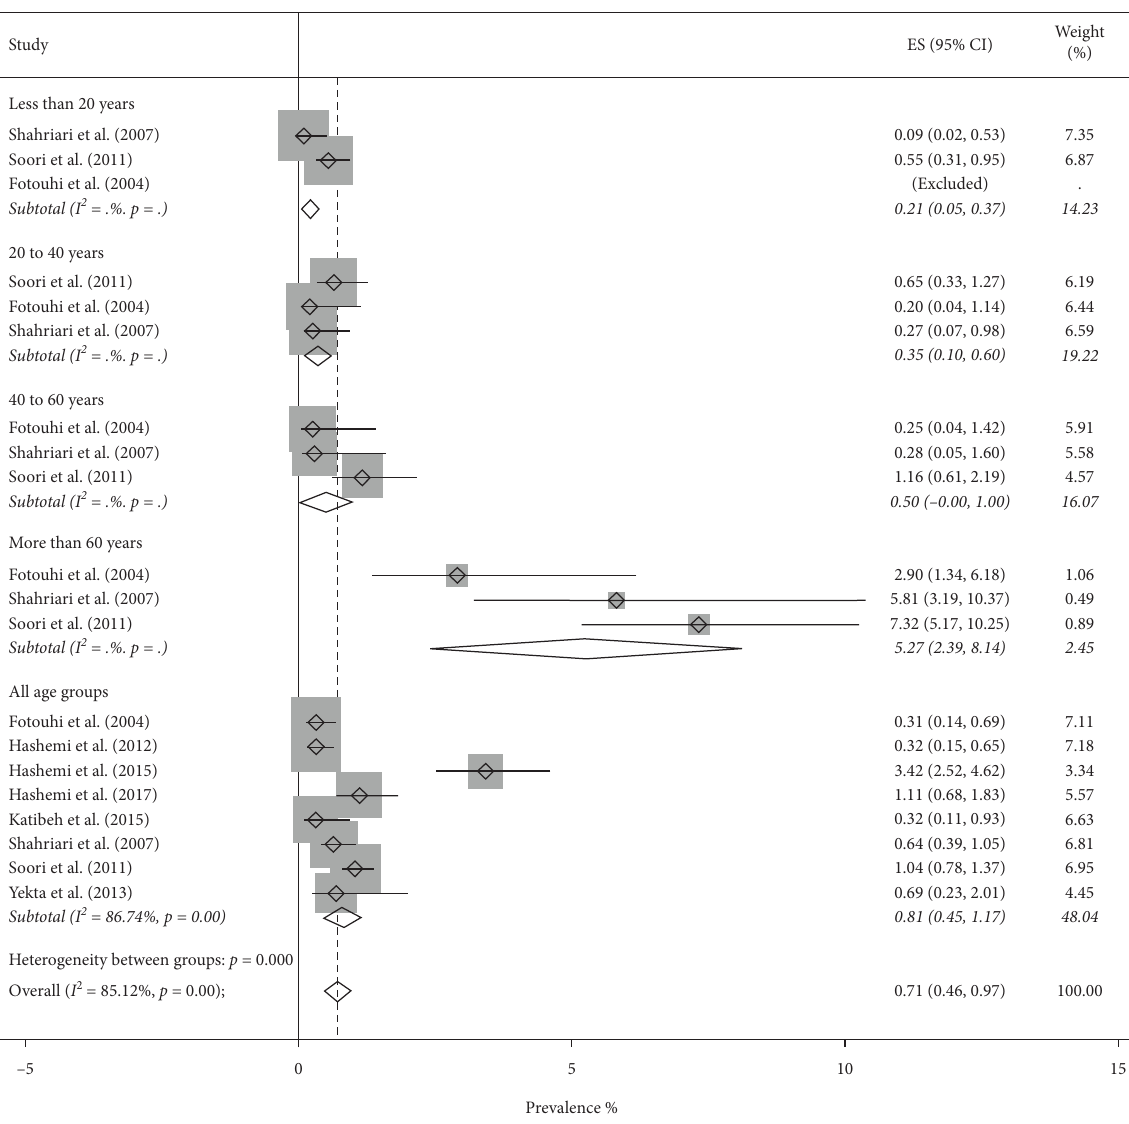
Figure 2: Forest plot of the prevalence of blindness among Iranian